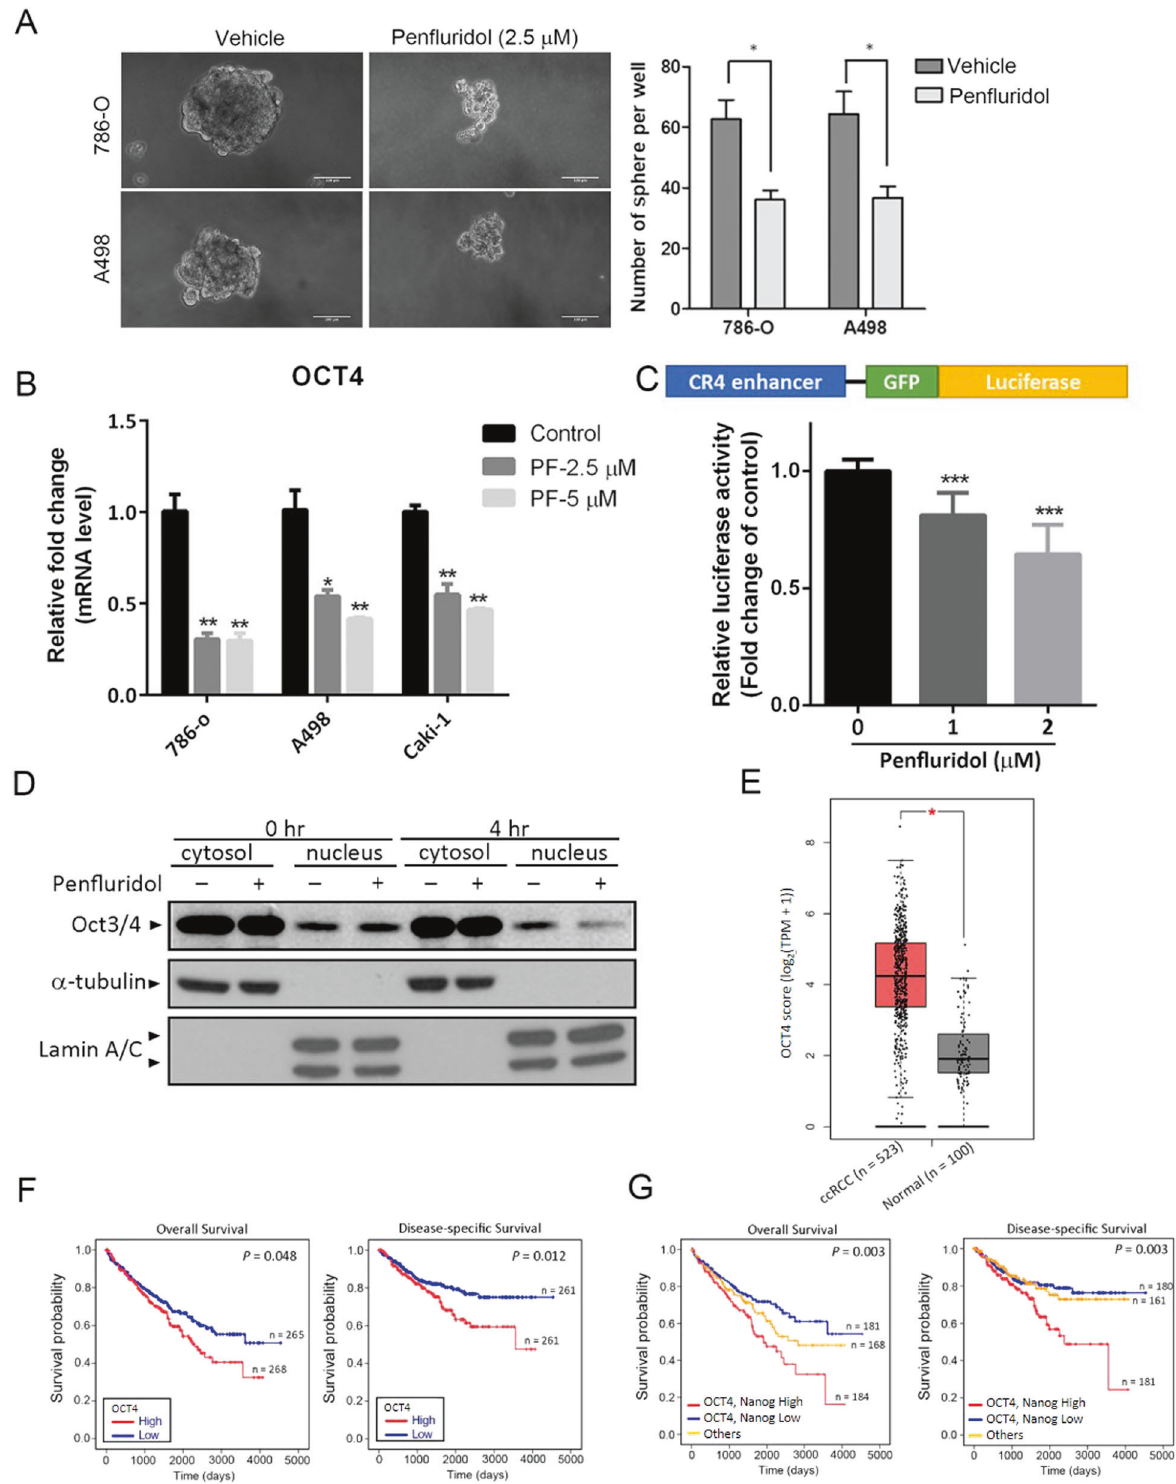
signi fi cantly reversed by both ER stress inhibitors in 786-O, A498, and Caki-1 cells (Fig. 2G and Supplementary Fig. 3). Pretreatment with 4-PBA also signi fi cantly reversed pen fl uridol- induced inhibition of colony formation in A498 cells (Fig. 2H). Taken together, the ER stress-mediated UPR is involved in pen fl uridol-induced autophagic cell death in ccRCC